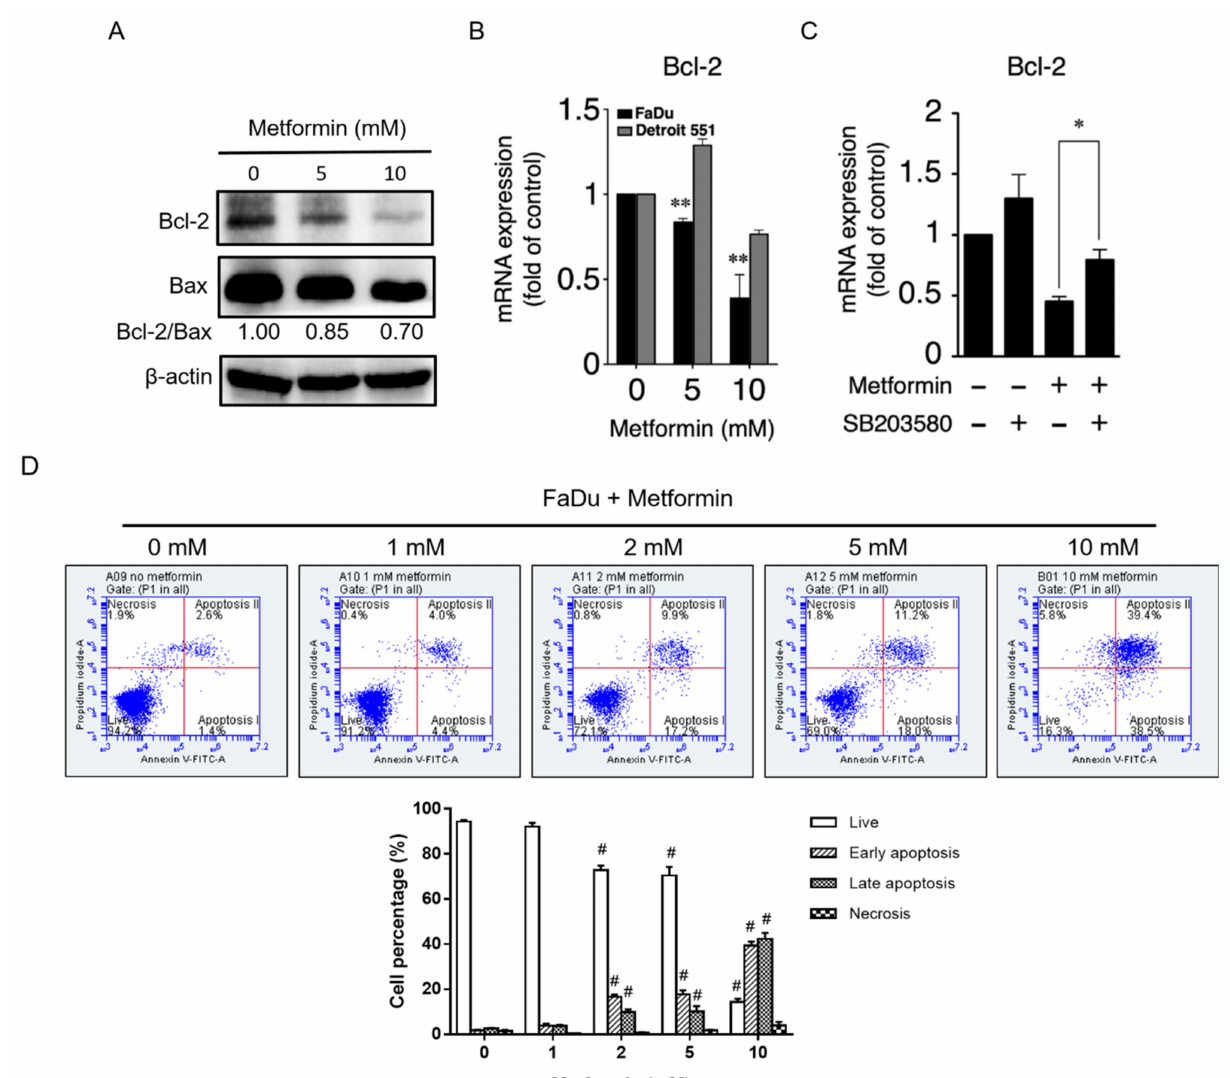
Figure 4. Metformin inhibited Bcl-2 expression in hypopharyngeal cancer cells and induced apoptosis expression. ( A ) FaDu cells were treated with 0, 5, and 10 mM of metformin for 48 h. Cell lysates were separated by SDS-PAGE and analyzed by Western blot assay with the indicated antibodies. ( B ) Treatment with metformin decreased the mRNA expression levels of Bcl-2 in FaDu but not in Detroit 551 cells. FaDu and Detroit 551 cells were treated with 0, 5, and 10 mM of metformin for 48 h. Bcl-2 mRNA levels were analyzed with qRT-PCR. Statistical significance indicates comparison analysis between the treatment and control group (0 mM). ( C ) Treatment with p38 inhibitor (SB203580) led to recovery of Bcl-2 mRNA expression levels in metformin-treated FaDu cells. ( D ) Treatment with metformin induces apoptosis of FaDu cells. Statistical significance was evaluated by Student’s t -test (* p < 0.05; ** p < 0.01; # p < 0.001 vs. 0